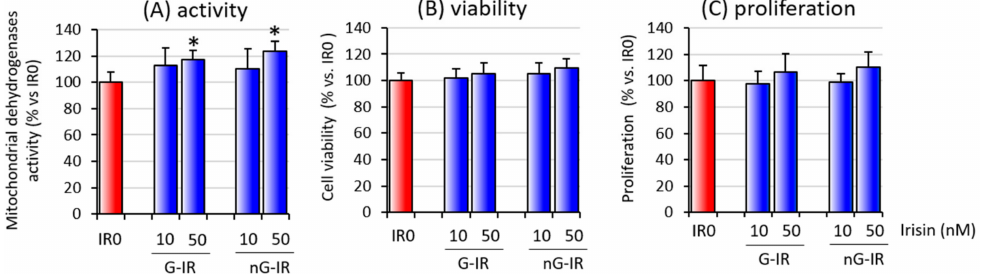
Figure 1. E ff ects of various forms of irisin (glycosylated (G-IR) or non-glycosylated (nG-IR)) on overall cellactivitymeasuredinanCellTitertest( A ).Viability( B )andproliferation( C )ofadipocyte–macrophage cocultures. Fully di ff erentiated adipocytes (3T3 L1) and macrophages (RAW 264.7) were cultured